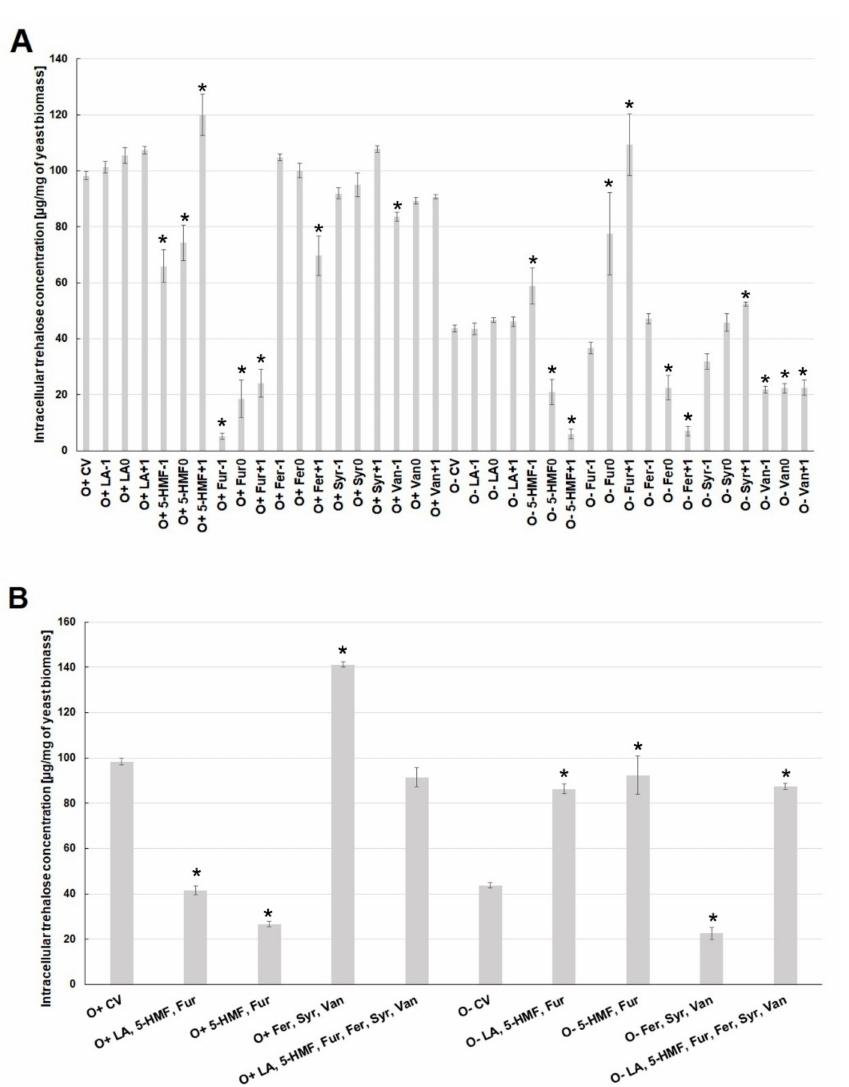
Figure 5. Effect of lignocellulose pretreatment by-products ( A , B ) on the production of intracellular trehalose by yeast (*—statistically different from the corresponding control variant α <